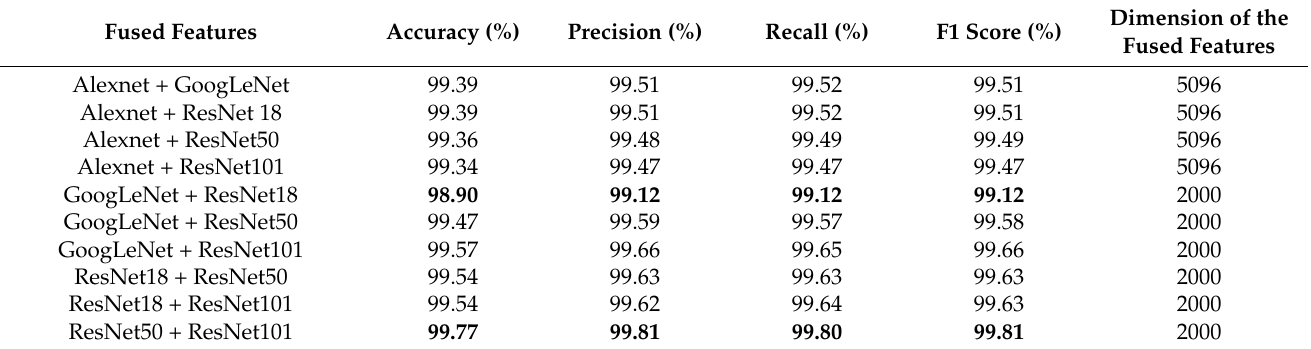
Table 5. Results of direct concatenation fusion method (bold font shows the best performance).